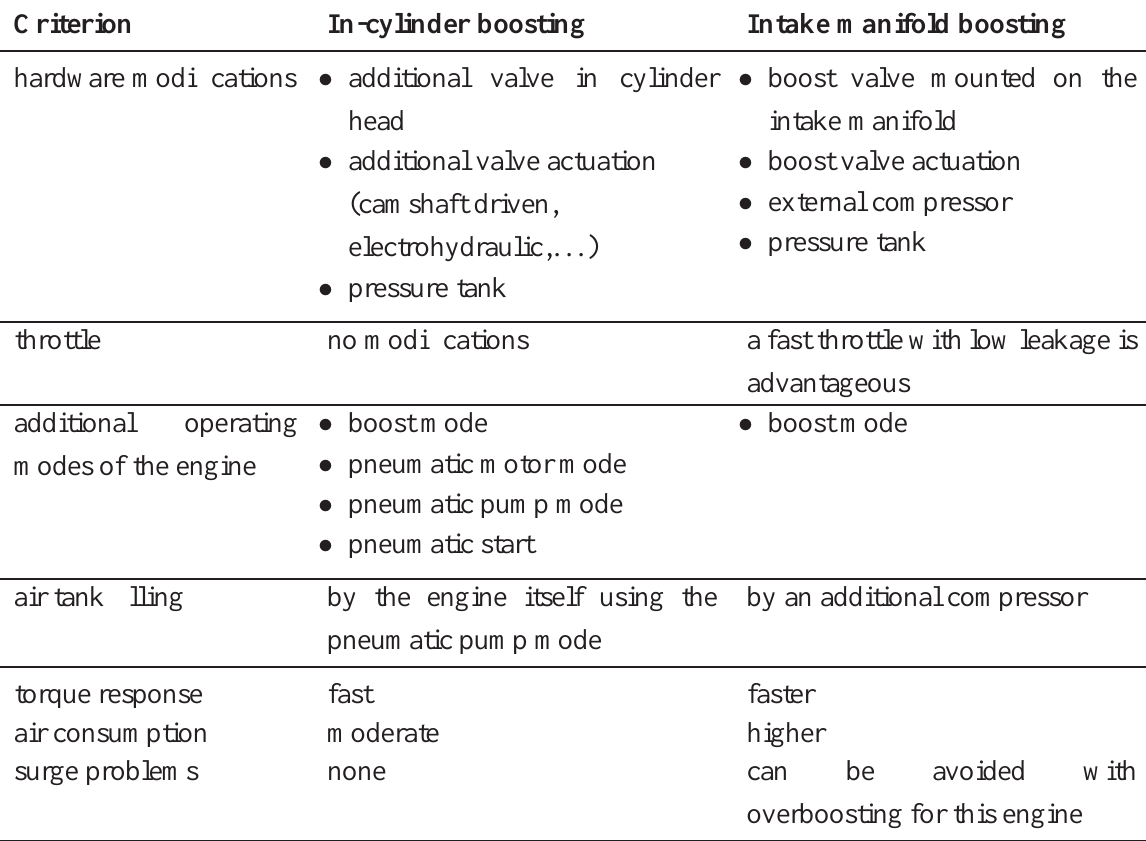
Table 3. Comparison of intake manifold and in-cylinder